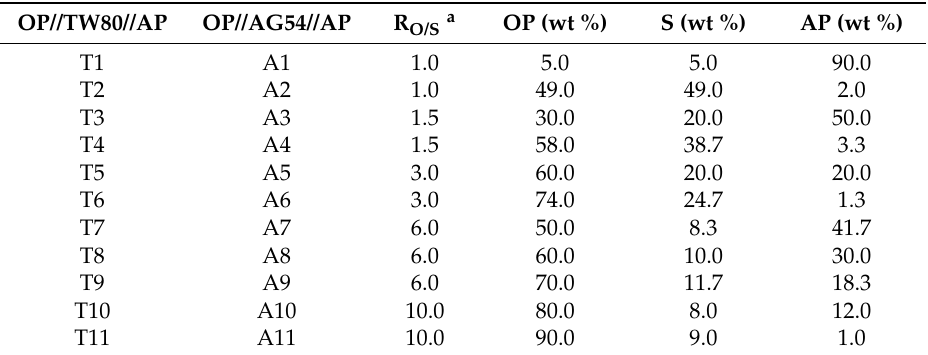
Table 1. Composition of different nanoemulsions.